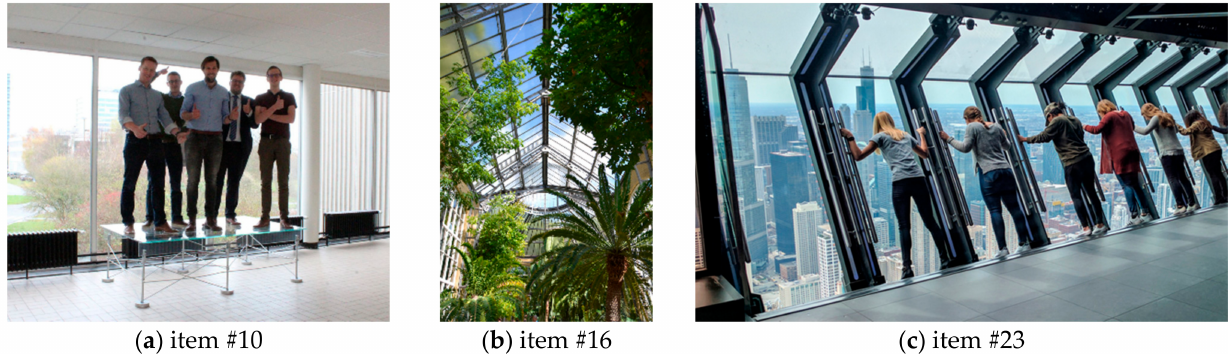
Figure 15. Static items with prevailing POS reactions: ( a ) mock-up of glass floor system (adapted from [61], © Vitroplena bvba, BE); ( b ); roof (Botanical Garden, Amsterdam, NL); ( c ) observation deck (360 Chicago Tilt, Chicago, USA; adapted from [62], ©